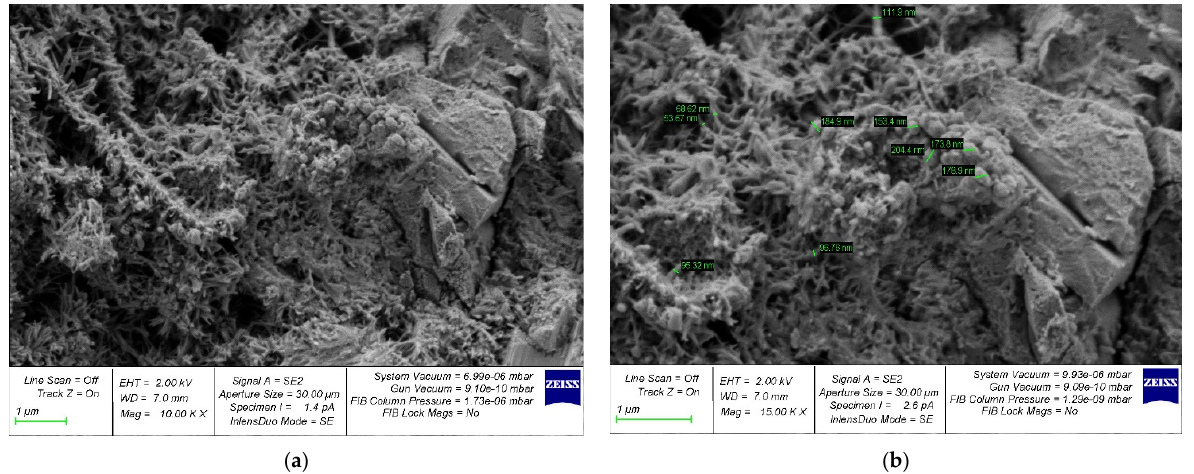
Figure 5. Samples with nanosilica content of 2.5% by weight of cement at magnifications of ( a ) 10,000× and ( b ) 15,000×.